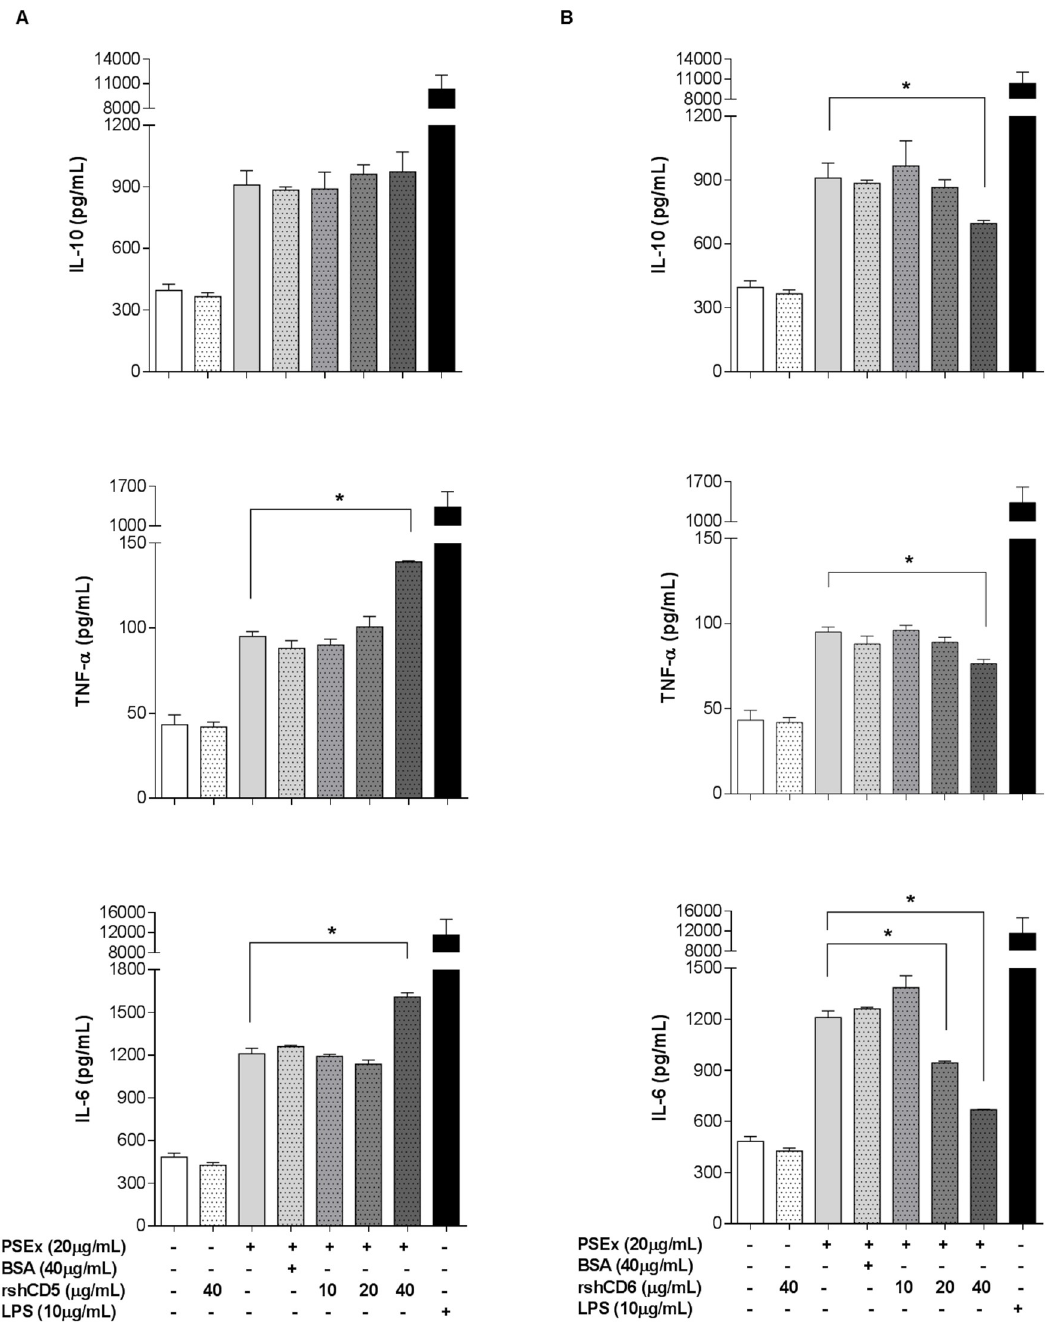
Fig 5. Modulation of PSEx-induced cytokine production by rshCD5 or rshCD6. ( A ) Peritoneal cells from na ï ve wild-type C57BL/ 6 mice (n = 3, pooled) were stimulated with a fixed concentration of PSEx (20 μ g/mL) for 72 h in the presence of the indicated amounts of rshCD5, BSA or LPS. Results are displayed as cytokine concentration in supernatants (mean +/- SEM). ( B ) Same as in ( A ) using the indicated amounts of rshCD6 instead of rshCD5. Both experiments were performed in quadruplicates. ( � ) Significant differences (Student’s t-test, P < 0.05) respect to cells stimulated only with PSEx.